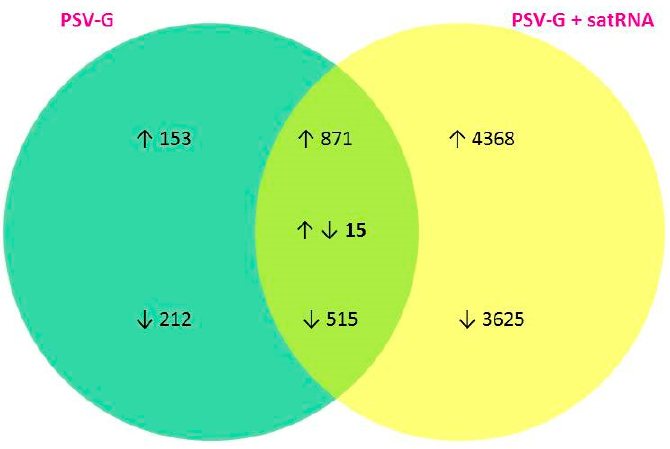
Figure 4. Venn diagram showing unique and common DEGs in PSV-G and PSV-G + satRNA plants. The arrows indicate up-regulated ( ↑ ) and down-regulated ( ↓ ) differentially expressed genes (DEGs). 3.3. Up-Regulated and Down-Regulated Plant Transcripts upon PSV Infection or PSV + satRNA Co-